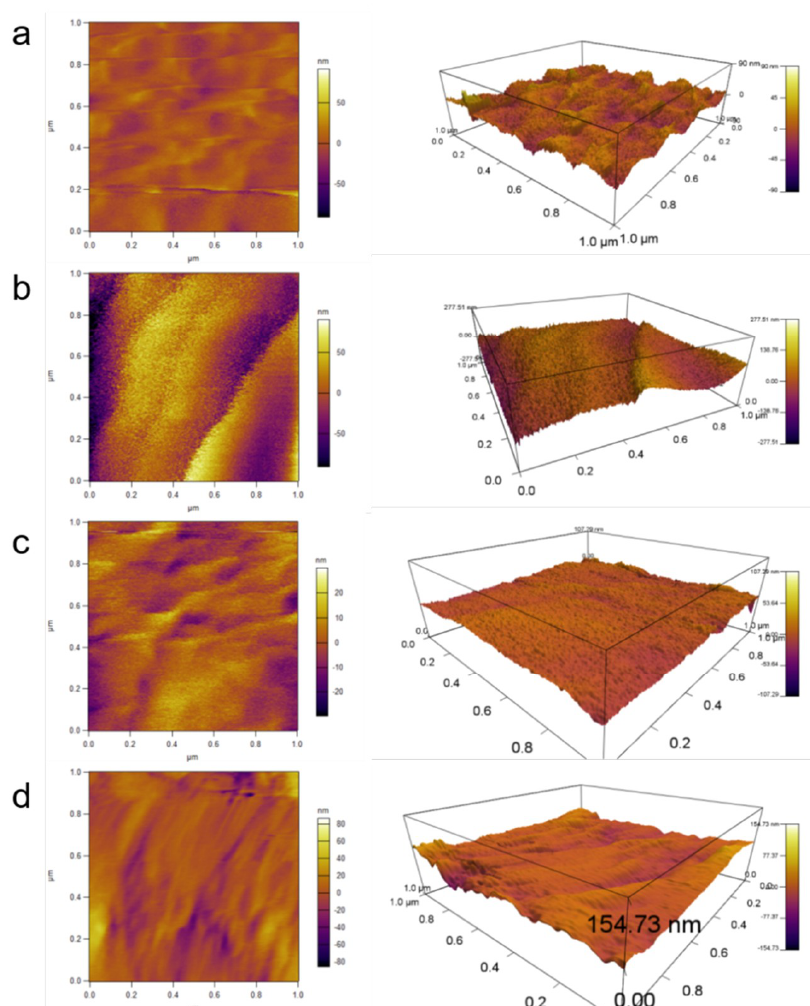
Figure 4. Two-dimensional and three-dimensional atomic force microscopy (AFM) images of the surface morphologies of the representative recovered recycled carbon fibers. (( a ) No. 5; ( b ) No. 2; ( c ) No. 15; and ( d ) No.